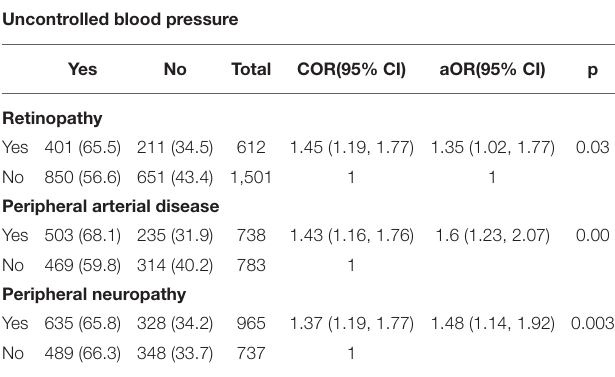
TABLE 3 | Association between uncontrolled blood pressure among persons with type 2 diabetes and complications. Uncontrolled blood